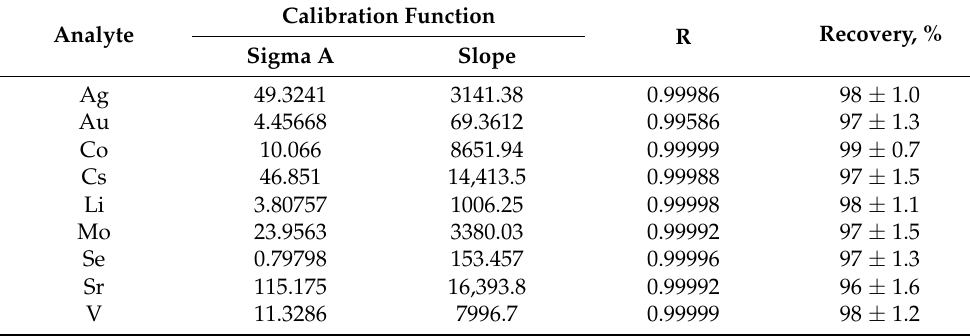
Table 4. The summary of the analytical calibration strategy and quality control results.